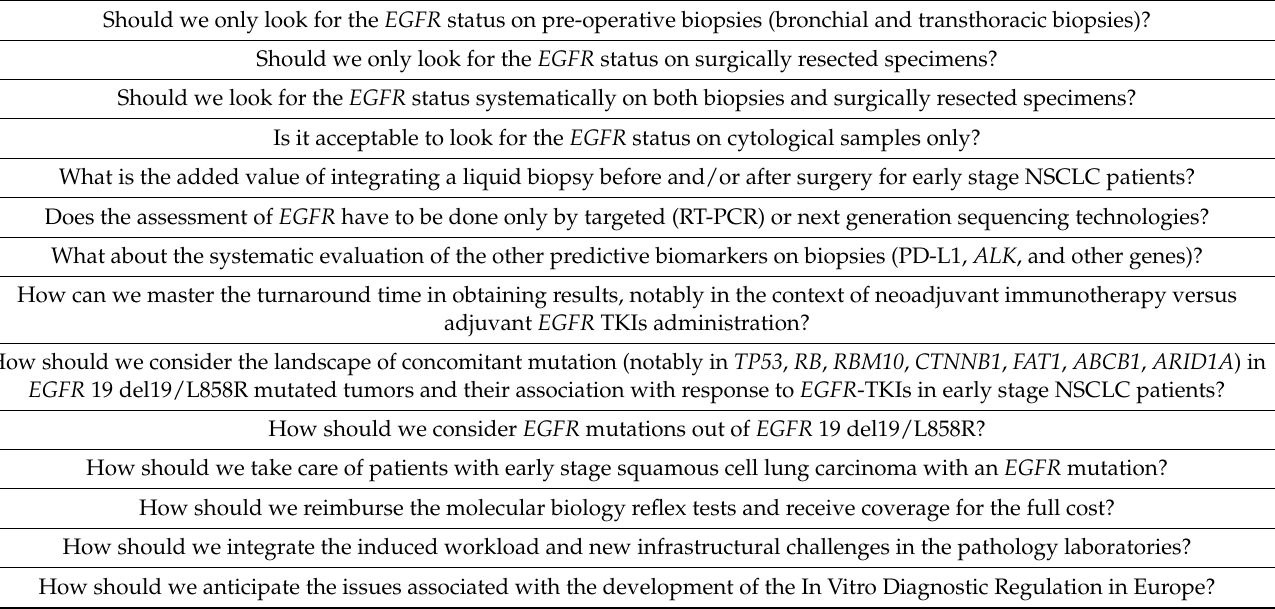
Table 1. Open current and future questions concerning the evaluation of EGFR status of early stage NSCLC patients in the context of neoadjuvant and/or adjuvant therapies using EGFR TKIs.